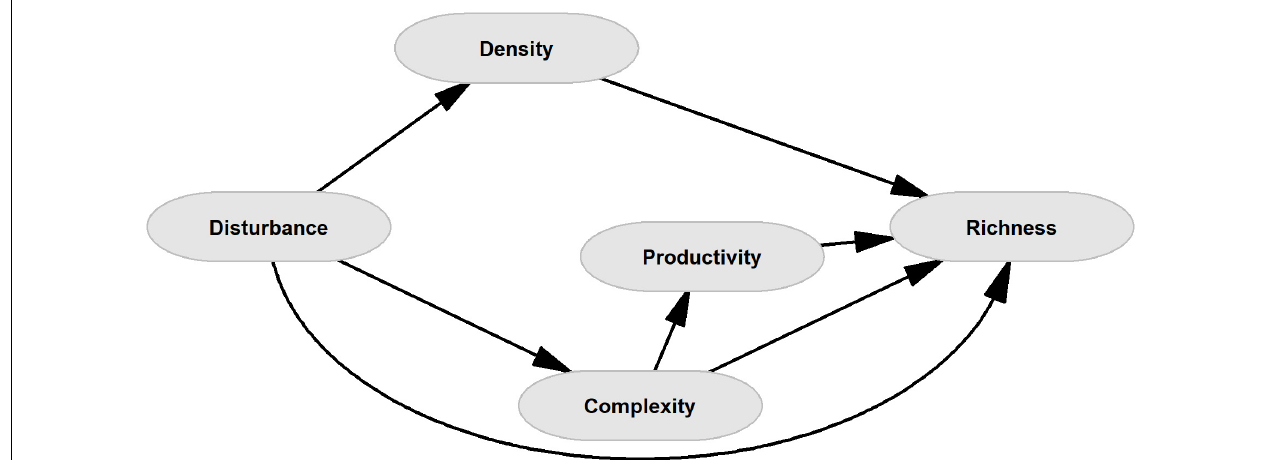
FIGURE 1 | General conceptual causal model for direct and indirect pathways of loss of species richness. Arrows represent causal pathways. Disturbance represents the chronic disturbance measured as the first component of the PCA of distance to populated centers, roads and farms. The model considers that chronic disturbances can affect the species richness of woody plants (Richness) directly, or through three indirect pathways: reduction of large tree density (Density), reduction of the forest structural complexity, which is based on the tree height and basal area (Complexity), or reduction of primary productivity, measured as normalized differentiation of vegetation Index (NDVI) (Productivity), as a consequence of changes in the structural